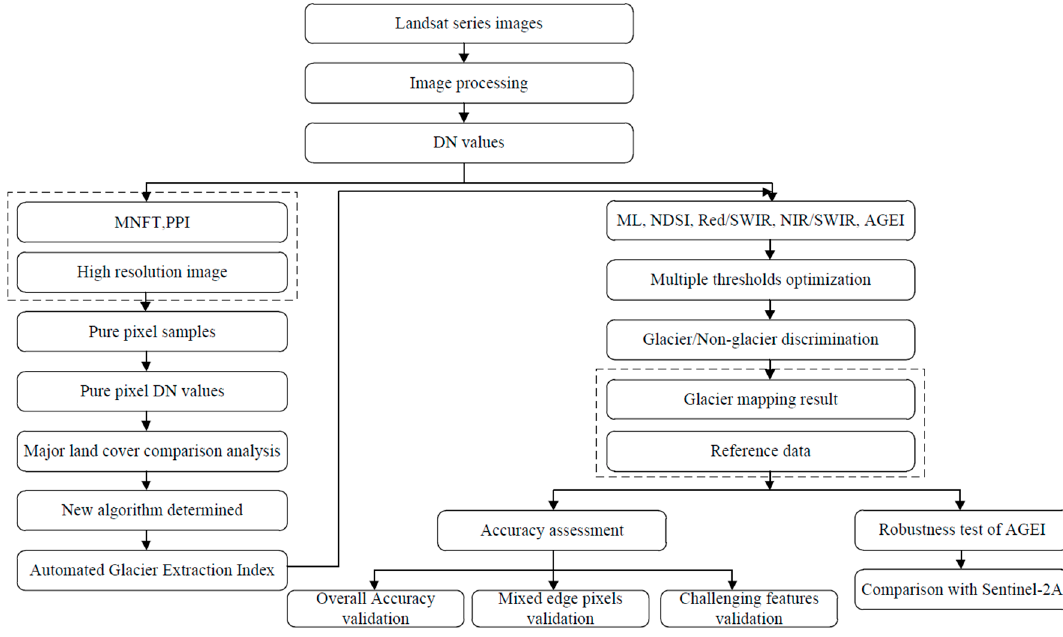
Figure 2. Methodology flowchart.